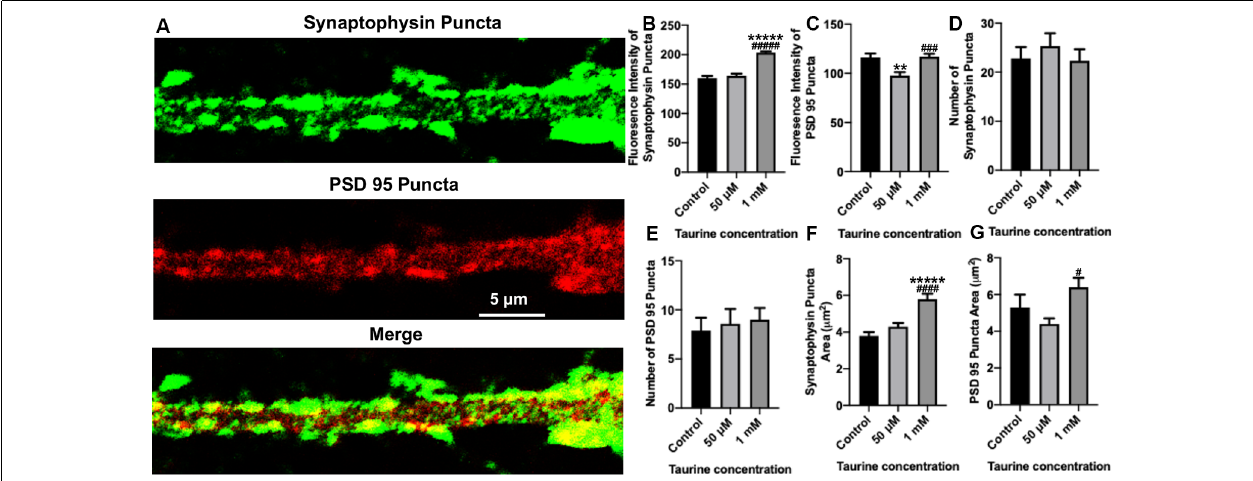
FIGURE 4 | In neurites, a higher concentration of taurine (1 mM) increases presynaptic puncta intensity and area while keeping postsynaptic puncta unaffected. Puncta parameters in neurites were examined by zooming in on a 1,000 µ m 2 primary neurite extending from a pyramidal neuron and using the ImageJ plugin SynQuant. (A) Representative fluorescent images show an example of the 1,000 µ m 2 , zoomed-in neurite from a 50 µ M taurine-treated neuron. (B) The intensity of synaptophysin puncta in the cropped, neurite image was measured and showed a significant increase in 1 mM taurine-treated neurons. The intensities of synaptophysin puncta in control was 159.7 ± 4.0, 50 µ M taurine was 163.6 ± 3.7, and 1 mM taurine was 203.4 ± 2.4 ( p < 0.00001 for control vs. 50 µ M taurine, and p < 0.00001 for 50 µ M taurine vs. 1 mM taurine). (C) The intensity of PSD95 puncta was significantly decreased in neurites cultured in 50 µ M taurine. The intensities of PSD95 puncta in control was 116.2 ± 4.0, in 50 µ M taurine was 97.6 ± 3.6, and in 1 mM taurine was 117 ± 2.9 ( p = 0.002 for control vs. 50 µ M taurine, and p = 0.0001 for 50 µ M taurine vs. 1 mM taurine). (D,E) The number of presynaptic synaptophysin and postsynaptic PSD95 puncta did not differ significantly between any treatments. Specifically, the number of synaptophysin puncta was 22.8 ± 2.3 for control, 25.3 ± 2.6 for 50 µ M taurine, and 22.3 ± 2.4 for 1 mM taurine ( p = 0.684). The number of PSD95 puncta was 7.9 ± 1.3 for control, 8.6 ± 1.5 for 50 µ M taurine, and 9 ± 1.2 for 1 mM taurine ( p = 0.852). (F) The area of synaptophysin puncta was measured and resulted in a significant increase for 1 mM taurine-treated neurons. The area of synaptophysin puncta for control was 3.8 ± 0.2 µ m 2 , for 50 µ M taurine was 4.3 ± 0.2 µ m 2 , and for 1 mM taurine was 5.8 ± 0.3 µ m 2 ( p < 0.00001 for control vs. 1 mM taurine, and p = 0.00002 for 50 µ M taurine vs. 1 mM taurine). (G) Taurine treatment at 50 µ M decreased the PSD95 puncta area, leading to a significant increase in puncta area of 1 mM taurine-treated neurites compared to 50 µ M treatment. The area of PSD95 puncta was 5.3 ± 0.7 µ m 2 for control, 4.4 ± 0.3 µ m 2 for 50 µ M taurine,